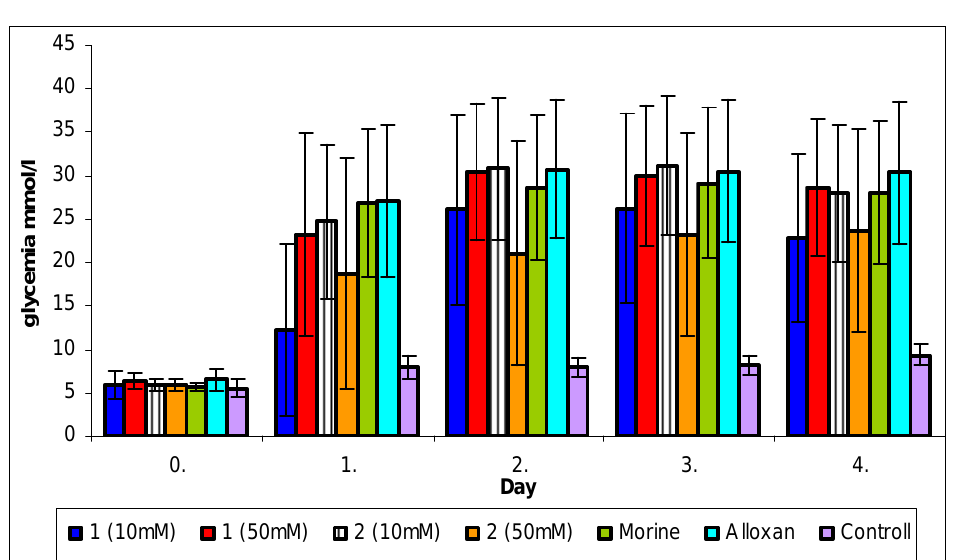
Figure 1. Levels of glycemia mmol/L as determined in alloxan induced diabetes testing of 1 and 2